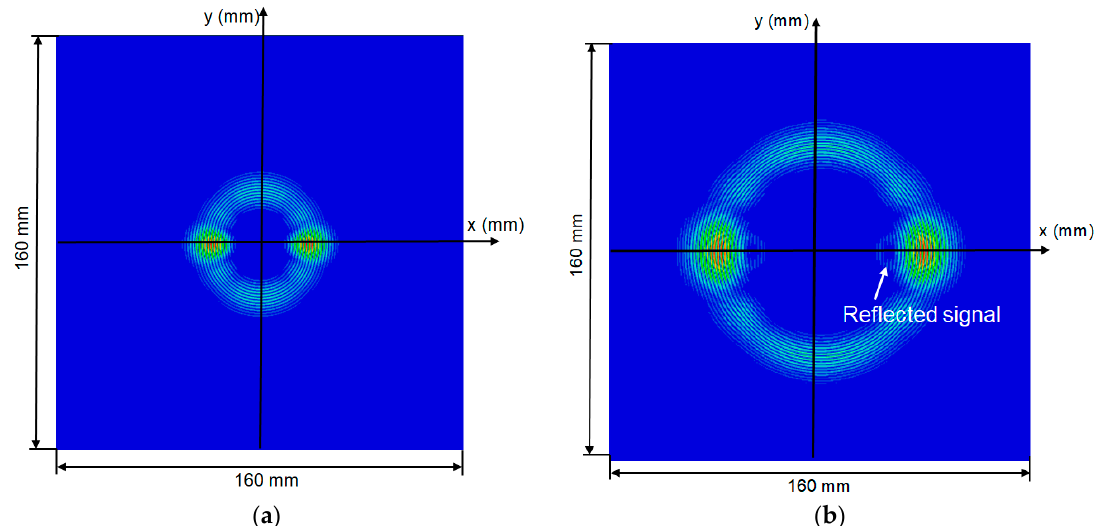
Figure 4. Spatial distributions of the normal particle velocity at two different time instants: ( a ) 150 μ s; ( b ) 246 μ s.